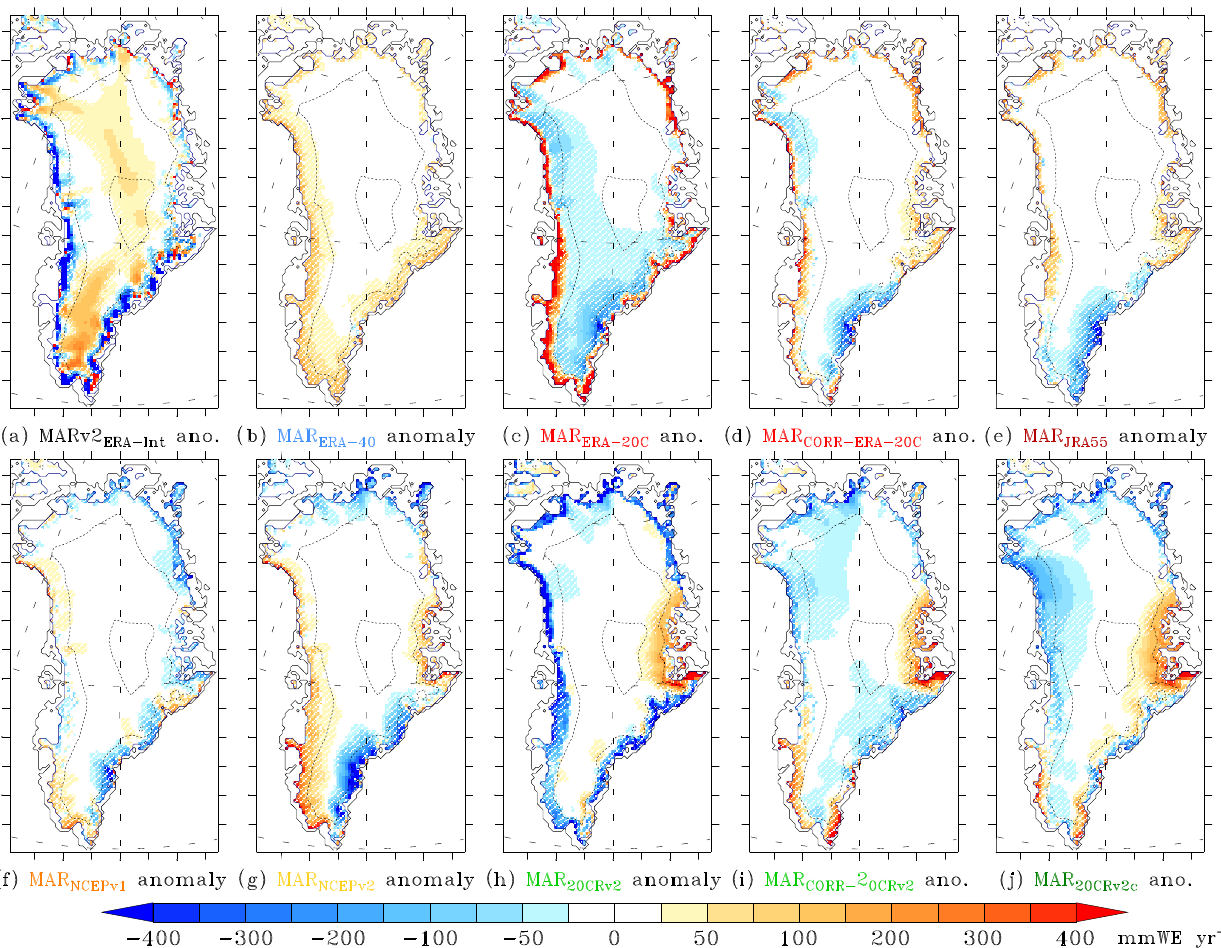
Figure 3. (a) Difference between the mean annual SMB (in mm.w.e.yr − 1 ) simulated by MARv2 forced by ERA-Interim and MARv3.5.2 forced by ERA-Interim over 1980–1999. (b) Difference between the mean 1980–1999 annual SMB simulated by MARv3.5.2 forced by ERA-40 and simulated by MARv3.5.2 forced by ERA-Interim. (c) Idem as (b) but for ERA-20C. (c) Idem as (b) but for CORR-ERA-20c. (e) Idem as (b) but for JRA-55. (f) Idem as (b) but for NCEPv1. (g) Idem as (b) but for NCEPv2. (h) Idem as (b) but for 20CRv2. (i) Idem as (b) but for CORR-20CRv2. (j) Idem as (b) but for 20CRv2c. Finally, the areas where the differences are lower than the interannual variability of MARv3.5.2 forced by ERA-Interim over 1980–1999 are